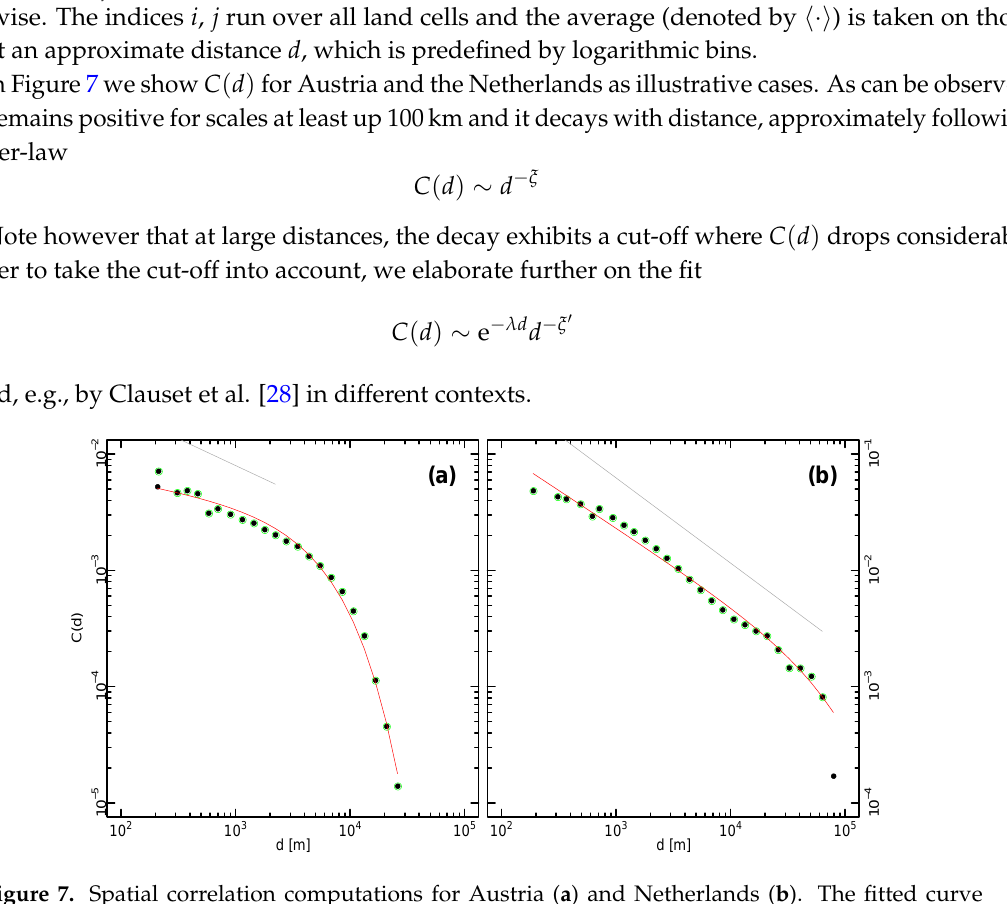
Figure 7. Spatial correlation computations for Austria ( a ) and Netherlands ( b ). The fitted curve (red) on the green-highlighted points which follows the function f ( x ) = c · x a · exp ( b · x ) (power-law with exponential cut-off) has the values for Austria ( a , b , c ) ≈ ( − 0.18, − 1.87 × 10 − 4 ,0.01 ) and for the Netherlands ( a , b , c ) ≈ ( − 0.65, − 1.05 × 10 − 5 ,2.02 ) . The grey lines (fitted on the corresponding points below the displayed part) have slopes ≈ − 0.46 for Austria and ≈ − 0.73 for the Netherlands. Beyond the shown range, C ( d ) fluctuates around